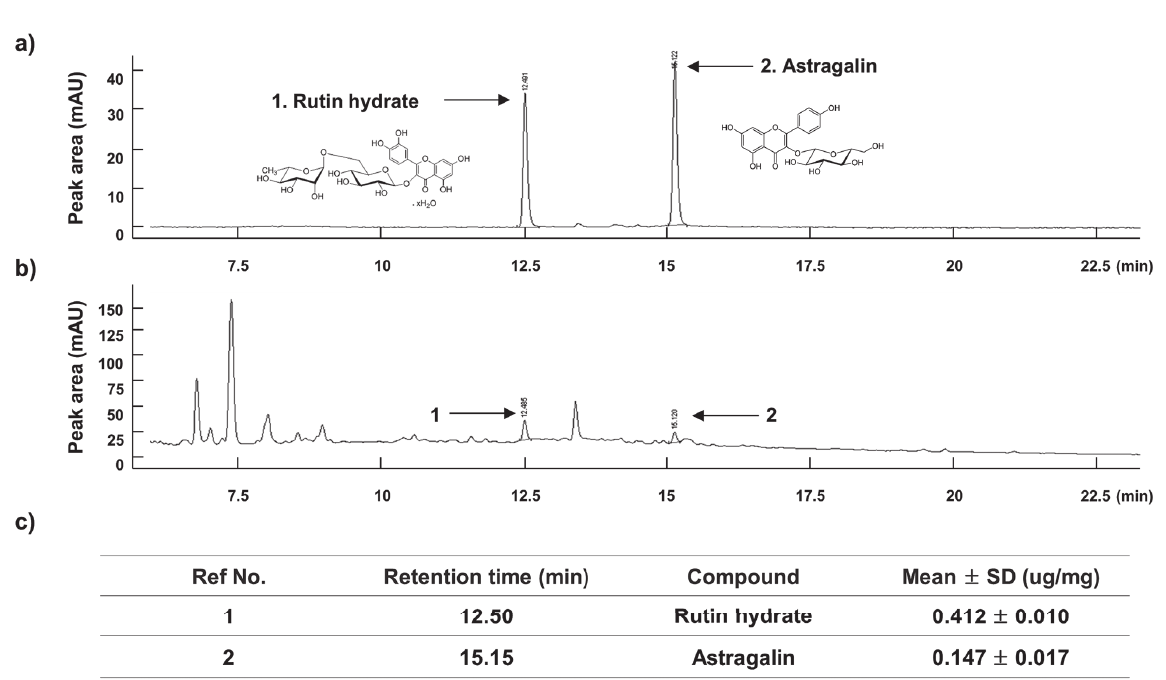
Figure 1 - Fingerprint analysis of WEMF using HPLC. The two reference components (a) and WEMF (b) were analyzed by HPLC analysis. The quantitative data of WEMF (c) for rutin hydrate and astragalin were